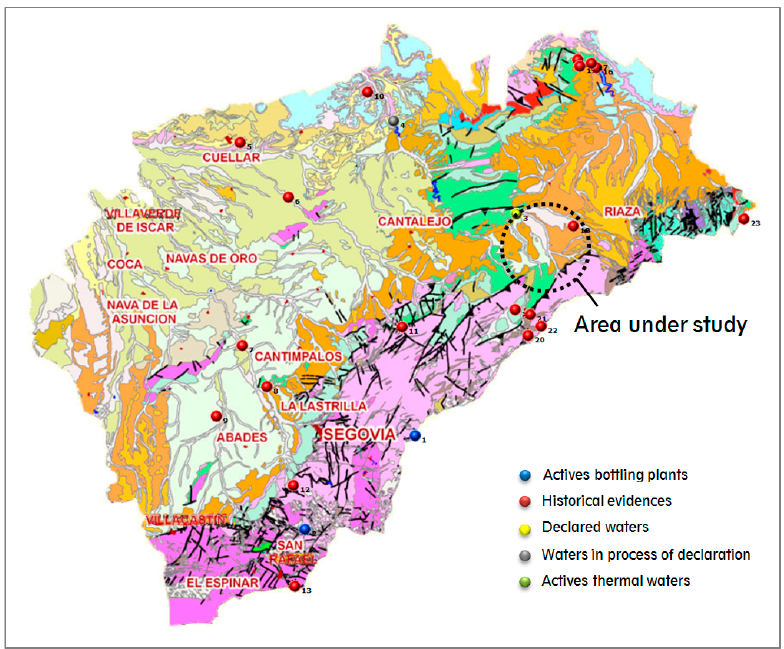
Figure 2. Thermal and mineral waters in Segovia, the Spanish province where the research is focused [22].